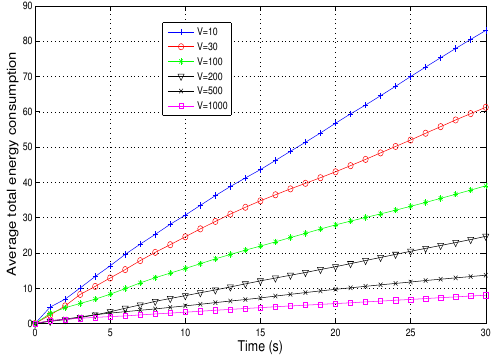
Figure 5. Average total energy consumption vs. time.